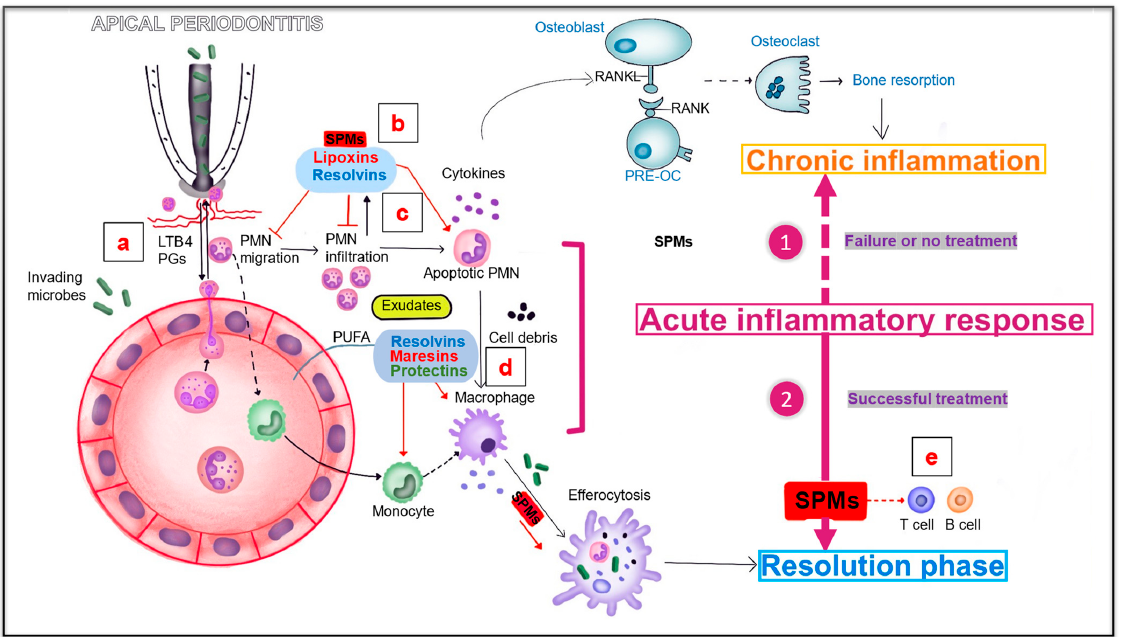
Figure 4. Specialized pro-resolving lipid mediators involved in apical periodontitis. ( a ) Bacterial invasion activates the migration and chemotaxis of polymorphonuclear neutrophils (PMNs) to the injury site by inducing chemotactic signals including LTB4. ( b , c ) SPMs including lipoxins and resolvins are derived from PUFA and may also be produced by resolving macrophages and apoptotic neutrophils. Lipotoxins can promote the clearance and phagocytosis of apoptotic neutrophils. Re- solvins can inhibit the migration, in fi ltration and accumulation of PMN. ( d ) Resolvins, maresins and protectins can promote the phagocytosis of apoptotic neutrophils and cell debris by macrophages. ( e ) SPMS can also play an active role on T cells and B cells by inhibiting T cell activity and inhibiting antibody production. Pre-OC, osteoclast precursor; PMN, polymorphonuclear neutrophil; LTB4, leukotriene B4; PGs, prostaglandins; SPMs, specialized pro-resolving mediators; PUFA, polyunsatu- rated fa tt y acid.